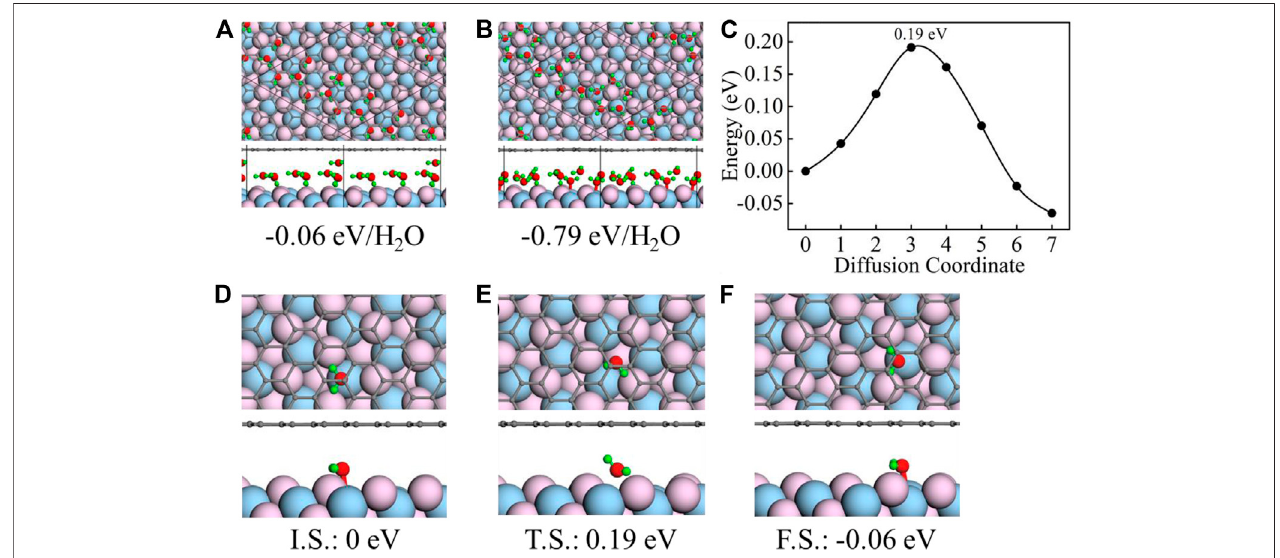
FIGURE 1 | Initial (A) and fi nal (B) geometric structures for the strati fi cation test along with their corresponding binding energies. (C) Calculated energy barriers for watermoleculediffusionbetweenCaF 2 (111)andgraphene. (D – F) Top-andside-viewgeometricstructuresoftheinitialstate(I.S.) (D) ,transitionstate(T.S.) (E) ,and fi nal state (F.S.) (F) ofwatermolecule diffusion betweenCaF 2 (111) and graphene.Thetotal energies forI.S., T.S., and F.S.are alldenoted inthe bottomasareferenceofI.S. In all panels, the black, red, green, fl esh pink, and light blue spheres represent the C, O, H, F, and Ca atoms,